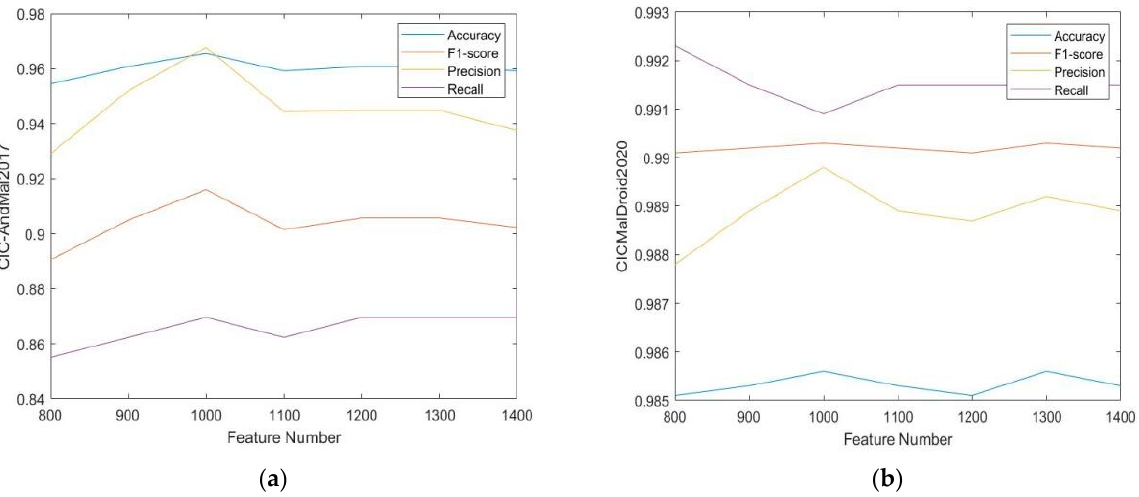
Figure 5. ( a ) CIC-AndMal2017: Comparison of seven feature sets; ( b ) CICMalDroid2020: Comparison of seven feature sets.